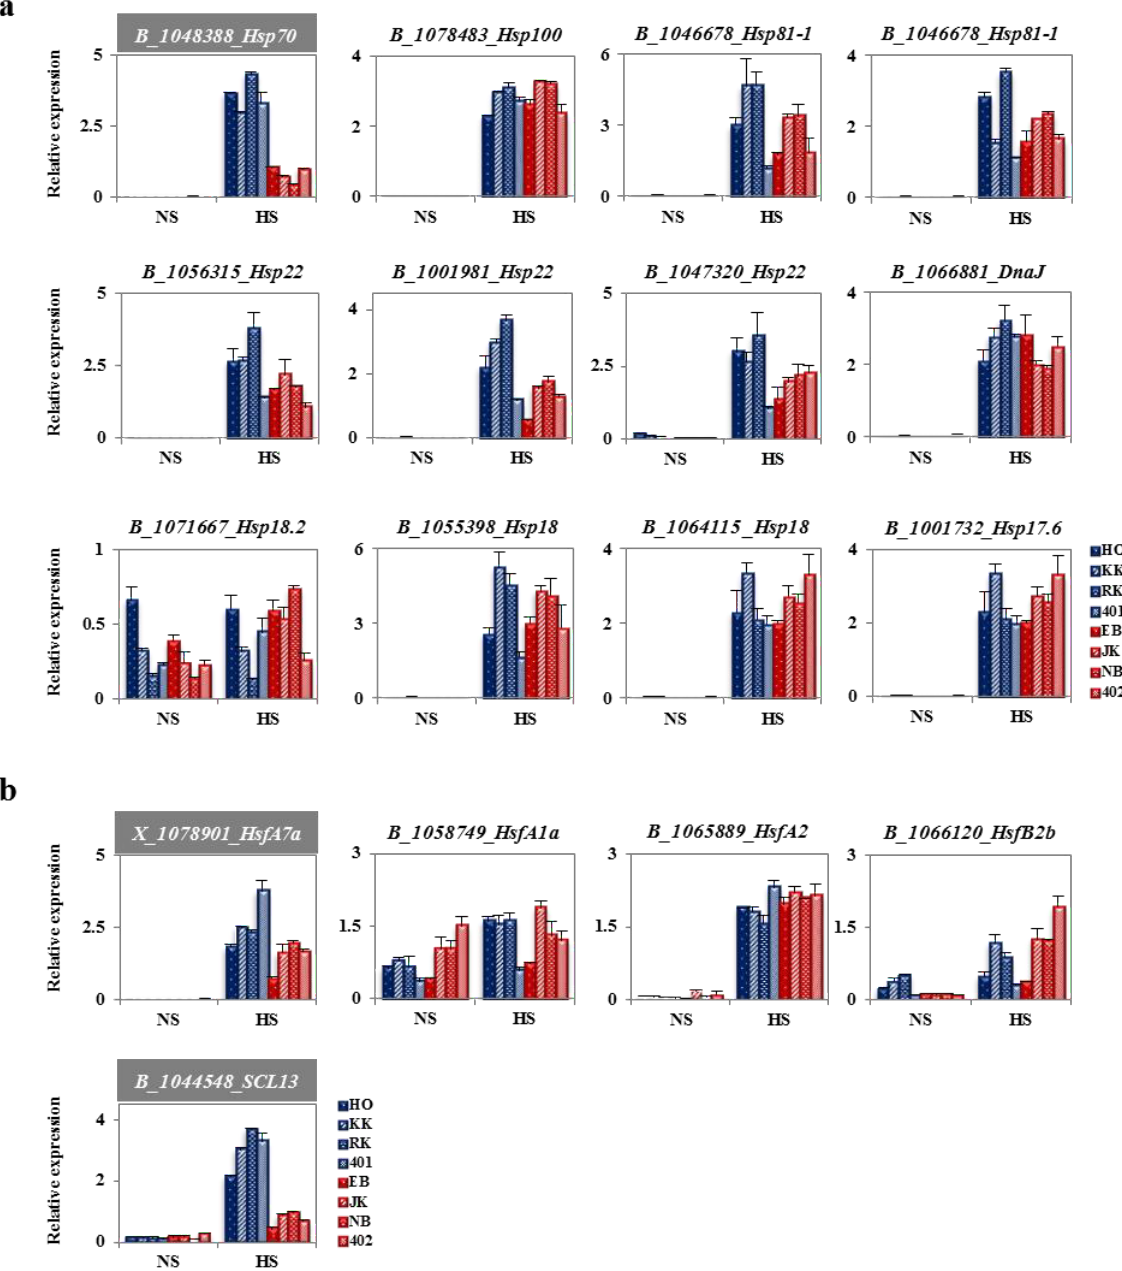
Figure 5. Analysis of fold change in expression of heat shock proteins and heat shock transcription factors in heat-tolerant and heat-sensitive cabbage lines. ( a ) Comparative change in fold expression of heat shock proteins in heat-tolerant cabbage lines (HTCLs) and heat-sensitive cabbage lines (HSCLs) . BoHsp70 , BoHsp100 , two BoHsp81s , three BoHsp22s , two BoHsp18s , BoHsp17.6 and Putative BoHsp ; ( b ) Comparative change in fold expression of heat shock transcription factors in HTCLs and HSCLs. BoHsfA1a , BoHsfA7a , BoHsfA2 , BoHsfB2b and BoSCL13 . HO, KK, RK and 401 are heat-tolerant cabbage inbred lines. EB, JK, NB and 402 are heat-sensitive cabbage inbred lines. Two-week old plants were exposed to heat stress at 42 °C for 4 h (HS) or incubated at 24 °C (NS). Expression levels were normalized to BoActin